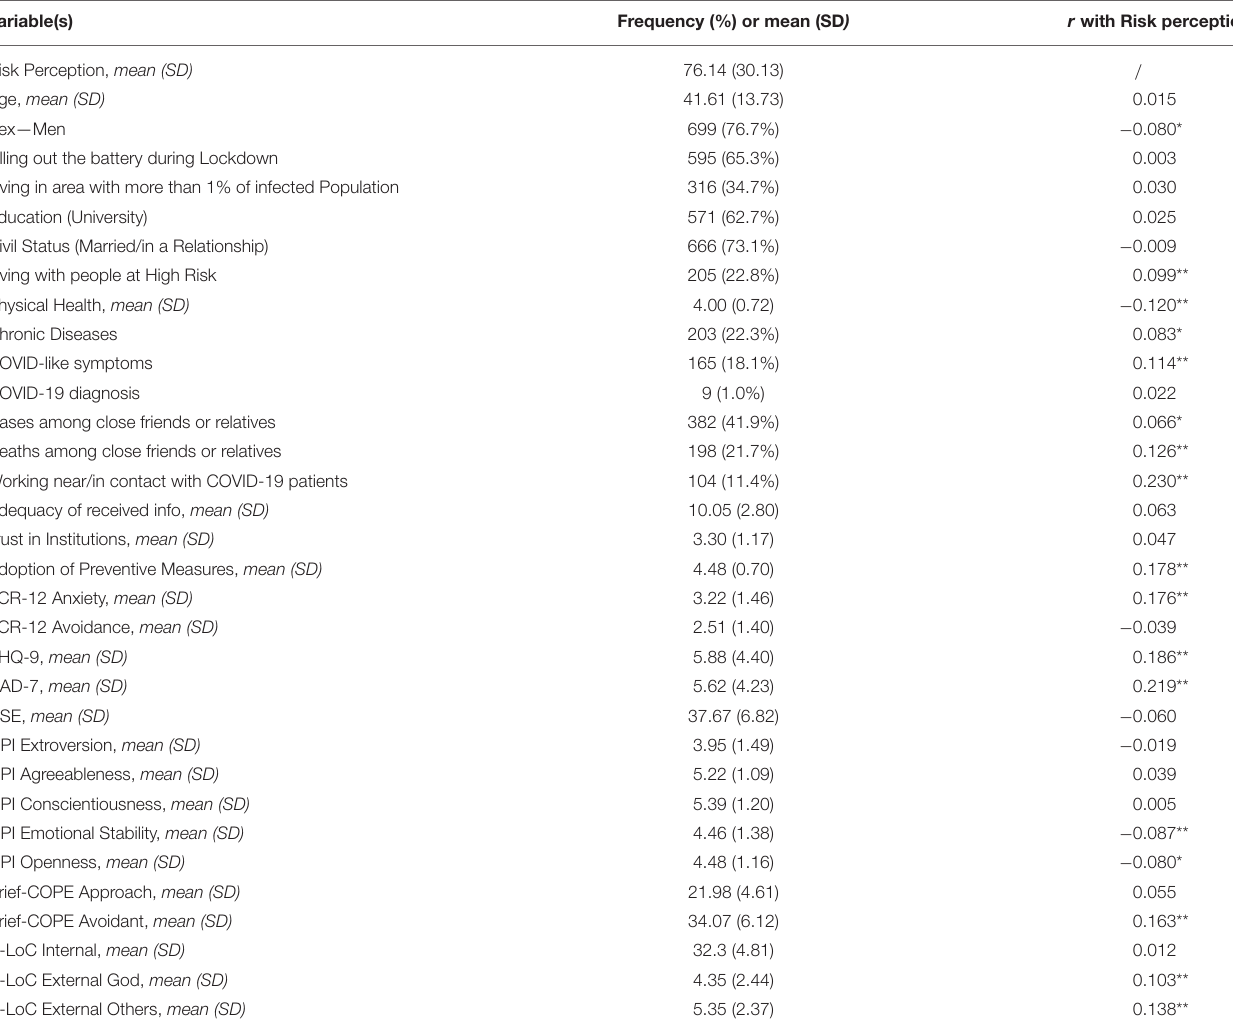
TABLE 1 | Means, standard deviations, frequencies, percentages for all sociodemographic, epidemiological, and psychological variables, and their associations with Risk Perception ( N = 911).